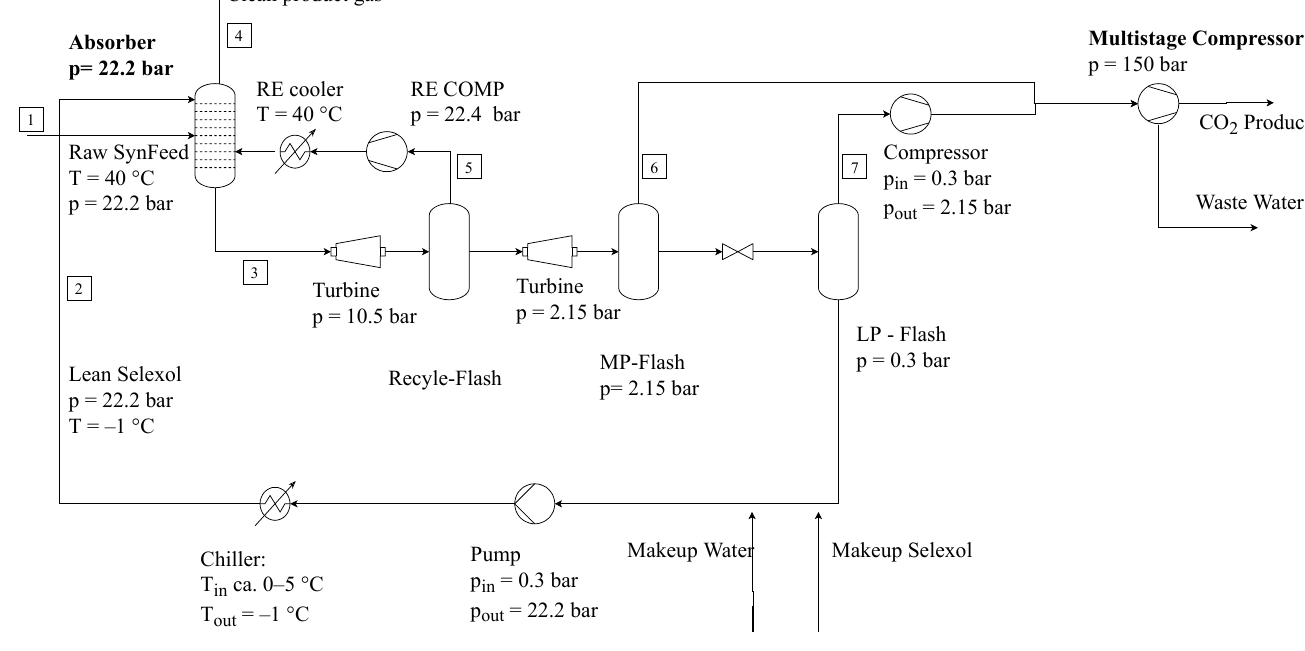
Figure 7. Process flow diagram of Selexol CO 2 -capture unit (Stream details for flows 1–7 in Appendix E).